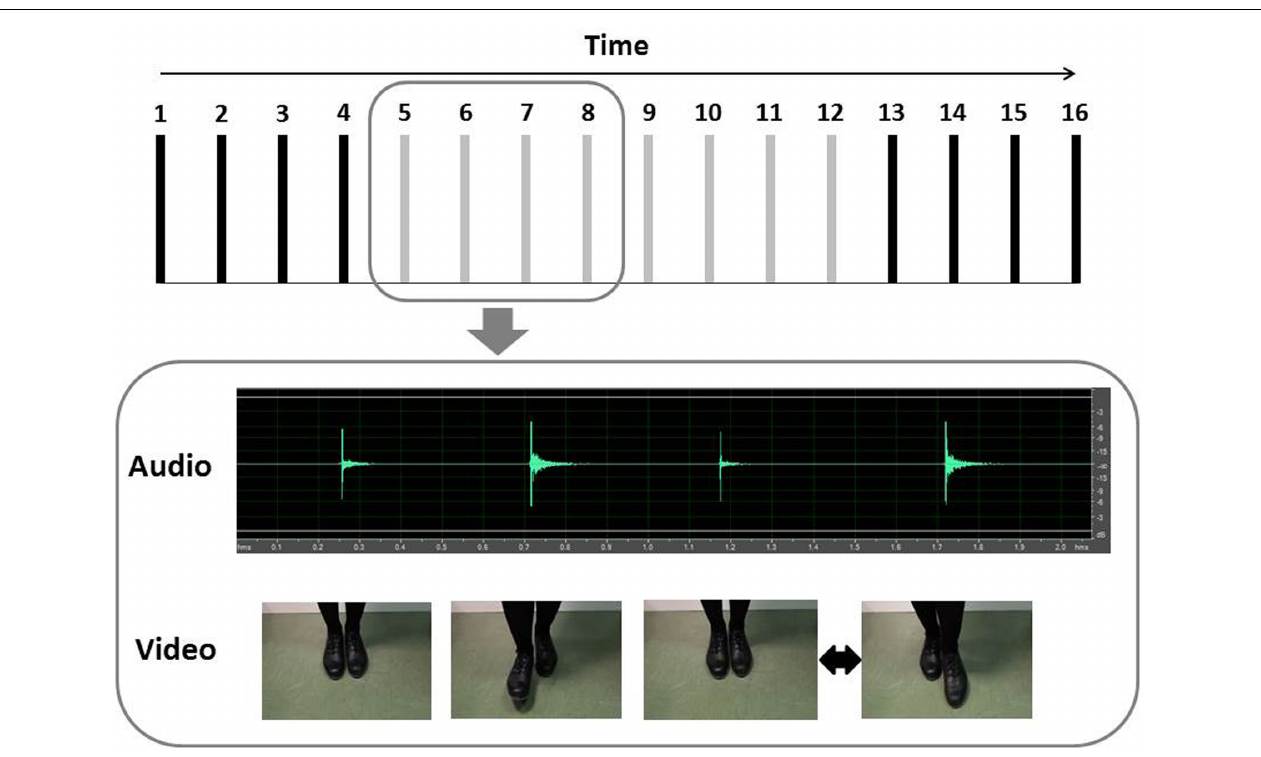
FIGURE 1 | Illustration of the stimuli. The structure of tap dance sequences is shown above, with each bar representing a step. In the RE trials, there was no temporal deviation. In the IR trials, the black bars represent the steps that were always regular and the gray bars represent the steps in which the temporal deviation (early or late step) could occur. In the lower half of the figure, we present a sample IR trial, in the auditory and visual modalities. In this exemplar, the temporal deviation occurred at the eighth